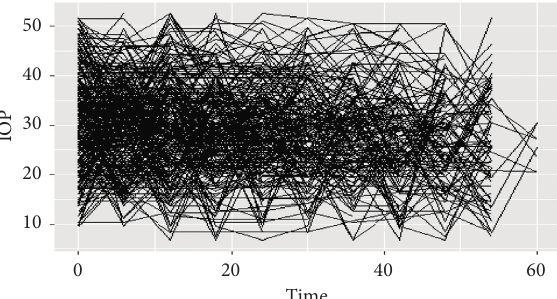
Figure 3: Individual profile plot for IOP of glaucoma patients.